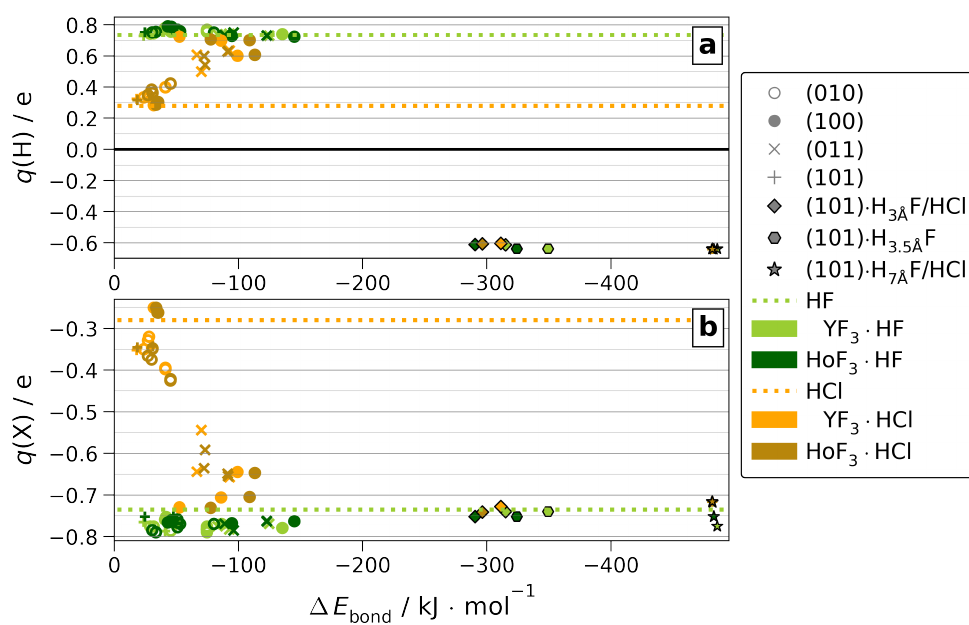
Figure 7. Partial Bader charges ( q (H) ( a ) and q (Cl)/ q (F) ( b )) of molecular HF or HCl (dotted lines) or adsorbed onto MF 3 (markers).